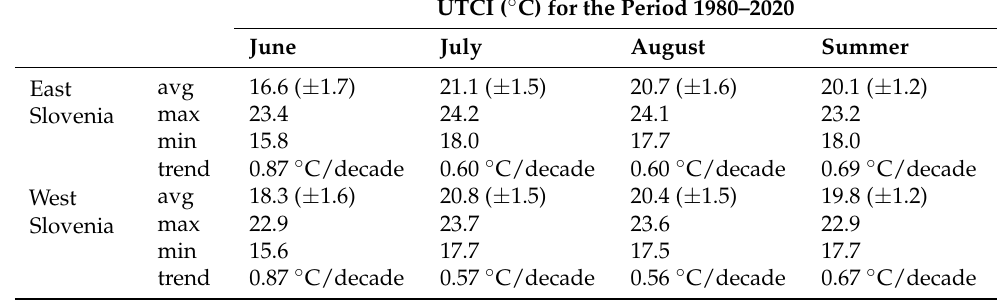
Table 4. Universal Thermal Climate Index (UTCI) average, maximum and minimum values, and trend for June, July, August, and the whole summer for the period 1980–2020 for East and West Slovenia.